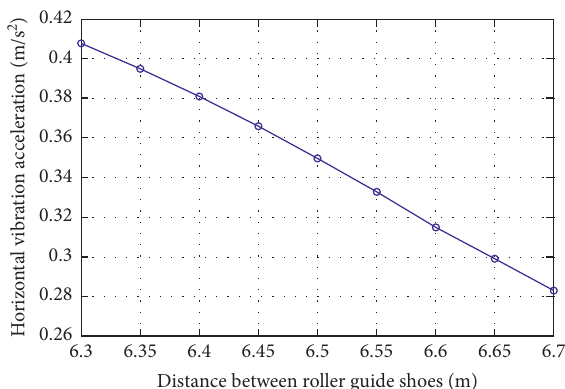
Figure 8: Influence of the guide shoe position on horizontal vibration of the